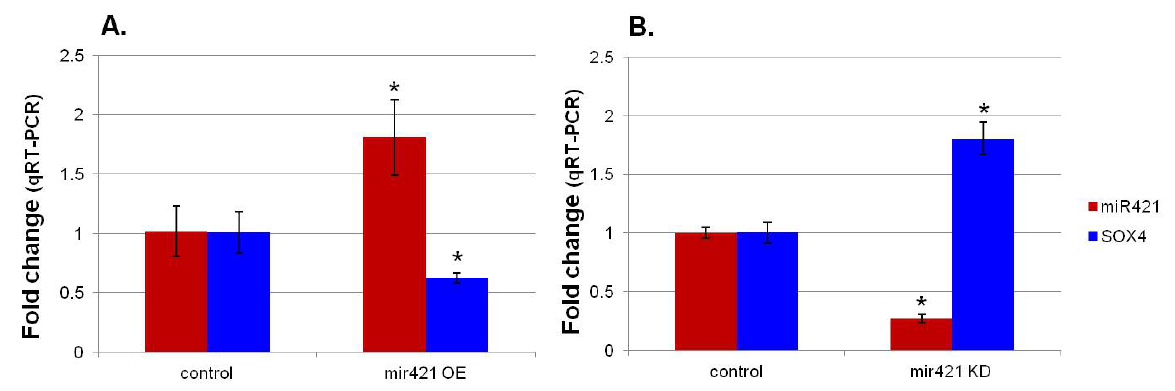
Figure 4. Transfections: ( A ) overexpression (OE) miR-421 in normal cardiomyocytes. ( B ) siRNA knockdown (KD) of miR-421 in primary cell cultures derived from the RV of infants with TOF. * significant change relative to starting level.